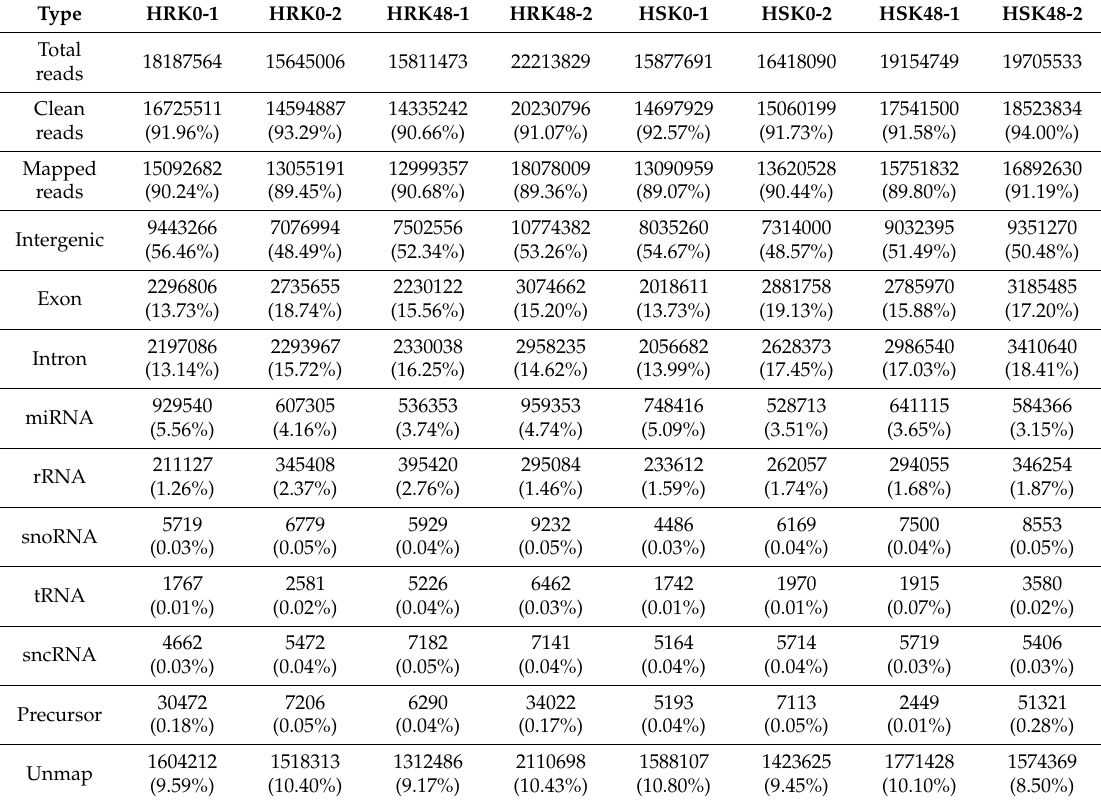
Table 1. Data statistics of the small RNA